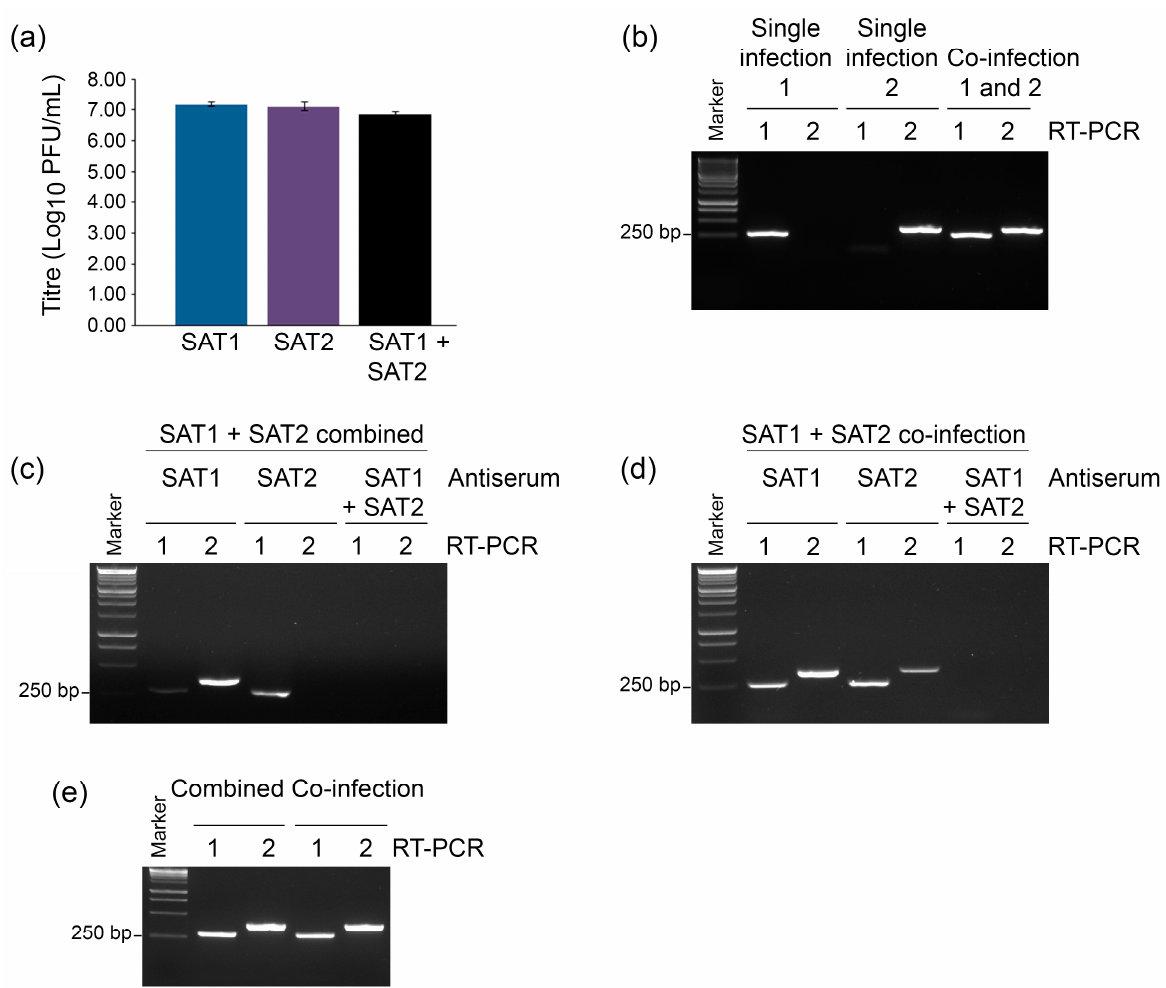
Figure 3. Trans-encapsidation between SAT1 and SAT2 serotype viruses enables escape from neu- tralizing antibodies. ZZ-R 127 cells were either co-infected with FMDV-SAT1 and FMDV-SAT2 or infected with each virus separately and processed as described in Figure 2a. ( a ) Viruses obtained from the separate infections and the co-infection were titered by plaque assay. ( b ) Viruses obtained from the separate infections and combined were subjected to RT-PCR analysis along with the products of the co-infection using FMDV-SAT1 (1) or FMDV-SAT2 (2) specific primer sets to confirm the presence of both genomes prior to incubation with antisera. ( c ) RT-PCR analysis of RNA purified from cells exposed to viruses obtained from the separate combined infections and incubated with anti-SAT1, anti-SAT2, or anti-SAT1 + anti-SAT2 antisera using SAT1 or SAT2 specific primers. ( d ) RT-PCR analysis of RNA purified from cells exposed to viruses from the co-infection incubated with anti-SAT1, anti-SAT2, or anti-SAT1 + anti-SAT2 antisera using SAT1 or SAT2 specific primers. ( e ) RT-PCR analysis of RNA from cells exposed to viruses incubated without antisera.